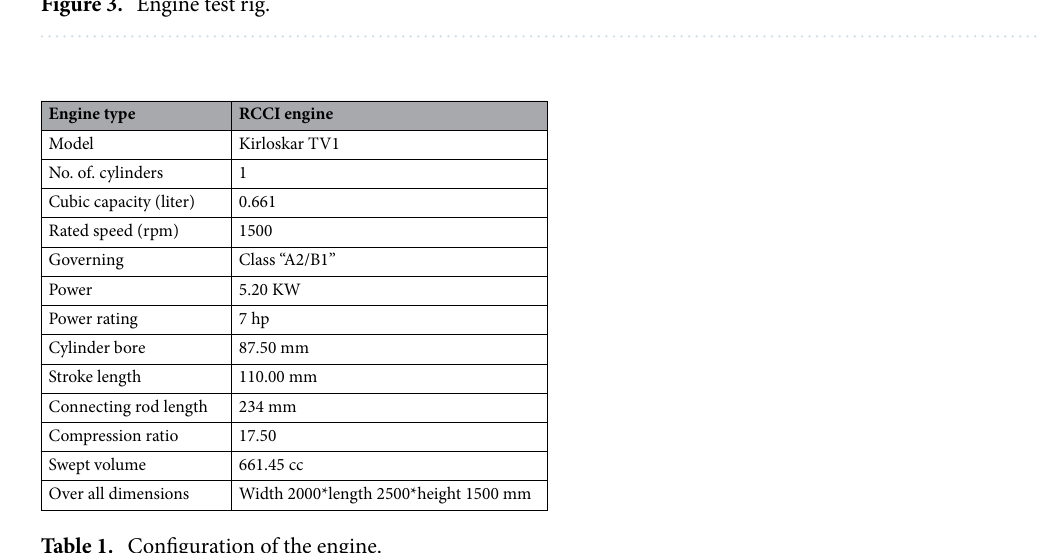
Figure 3. Engine test rig.